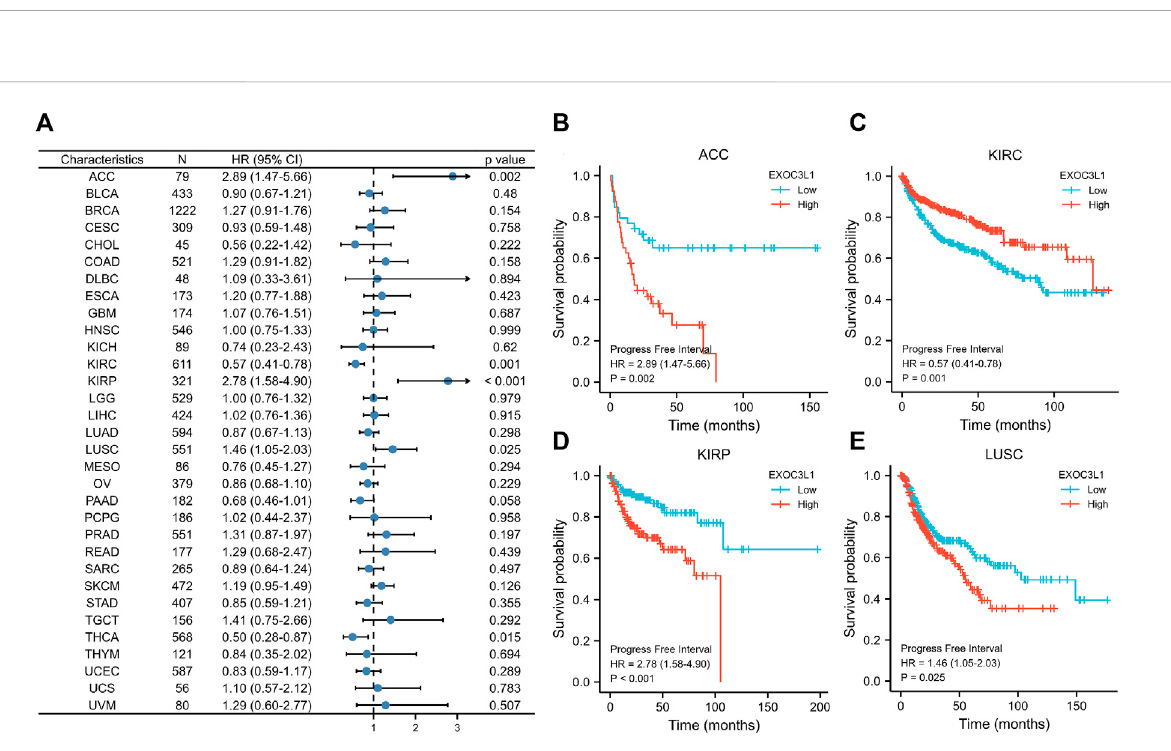
FIGURE 5 EffectofEXOC3L1 expressiononPFIinpan-cancer. (A) AforestmapoftherelationshipofEXOC3L1 expressiononPFIinTCGA. (B – E) Effectsof EXOC3L1 expression on PFI in ACC, KIRC, KIRP and LUSC,